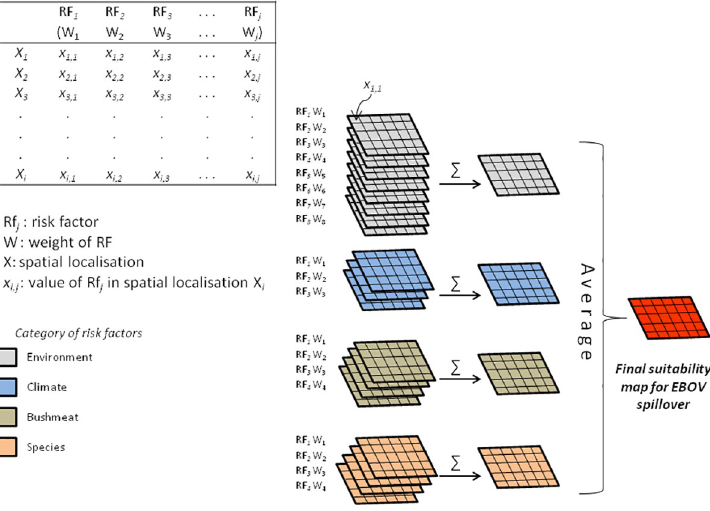
Fig 2. Schematic diagram of the GIS-MCE procedure followed to create the suitability maps for EBOV spillover.